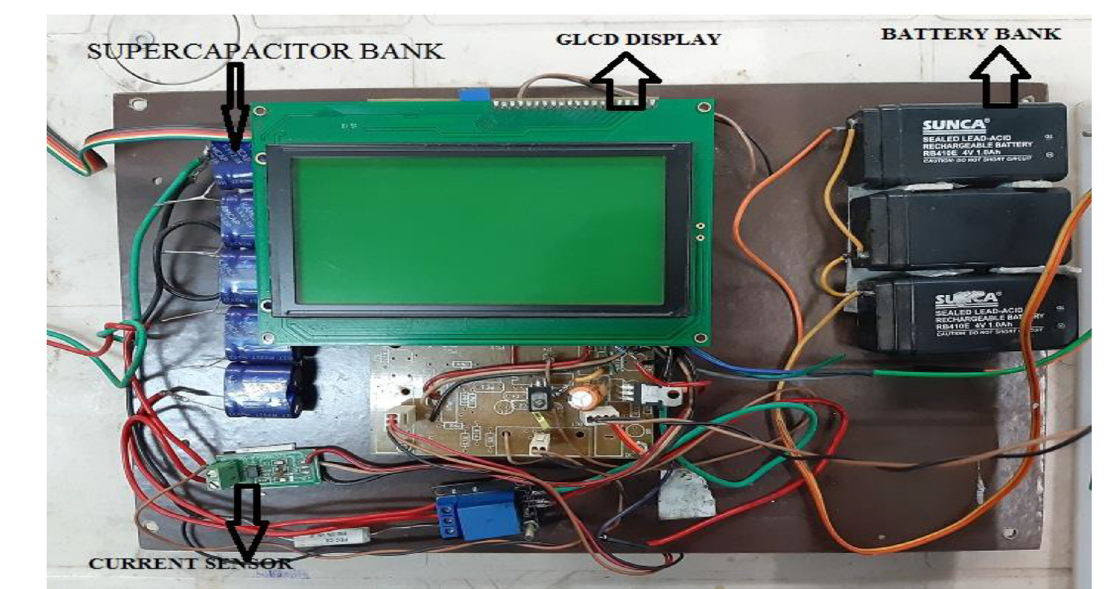
Fig. 3. Components of author V – I measurement